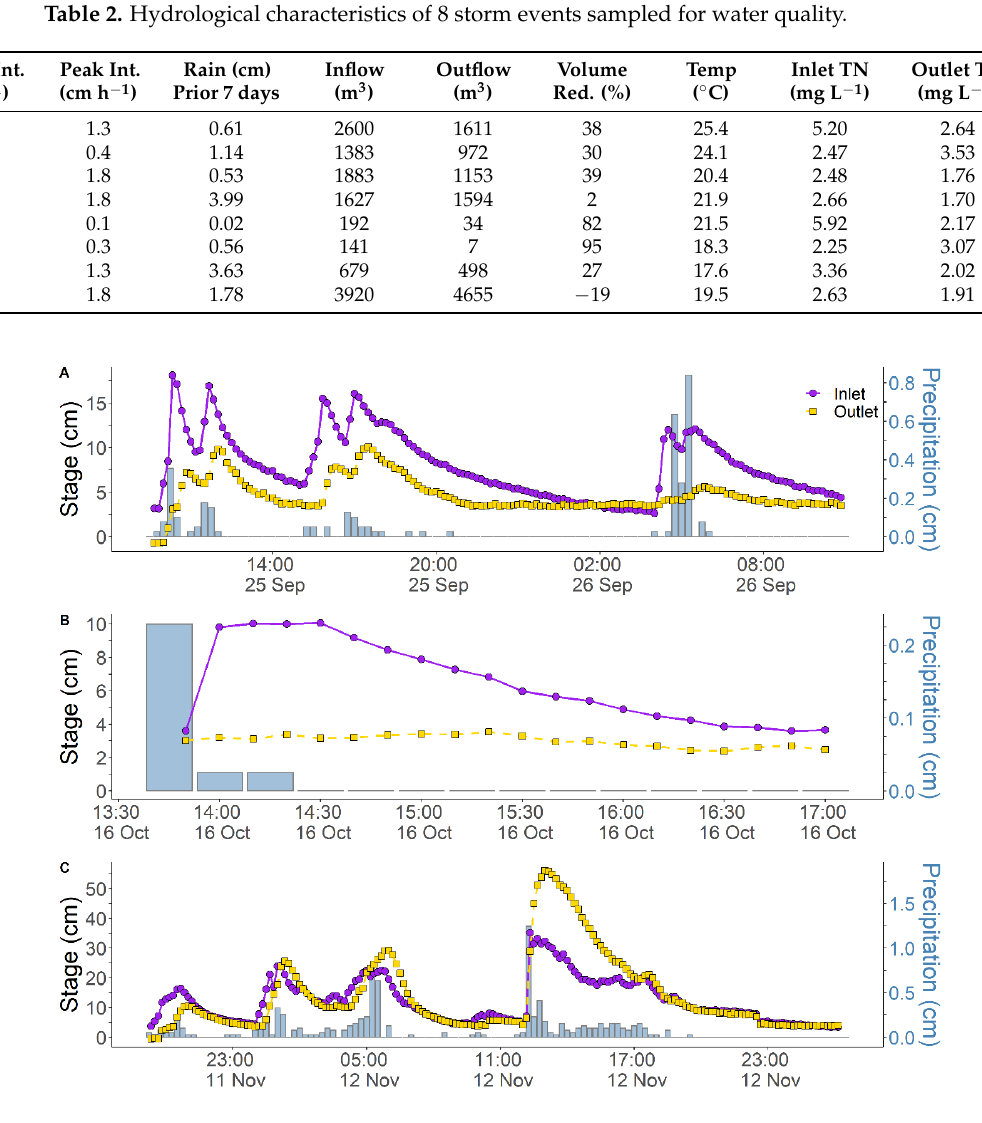
Figure 5. Hydrographs showing inlet- and outlet stage responses to rain events. ( A ) shows a storm during which a 38% reduction in outflow was observed, ( B ) shows a 95% reduction in outflow, and ( C ) shows a 19% increase in outflow, likely due to groundwater